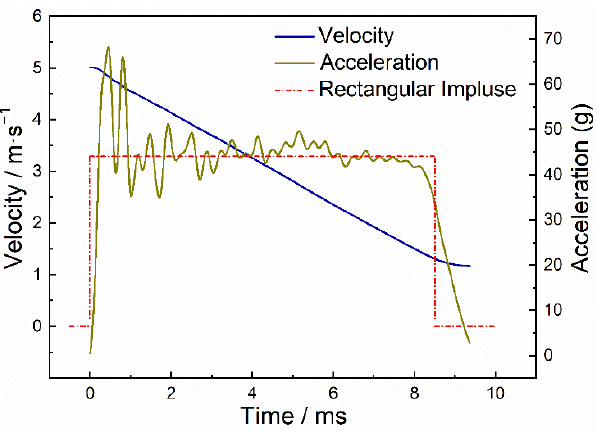
Figure 5. Typical acceleration and velocity curves for closed-cell Al foam.